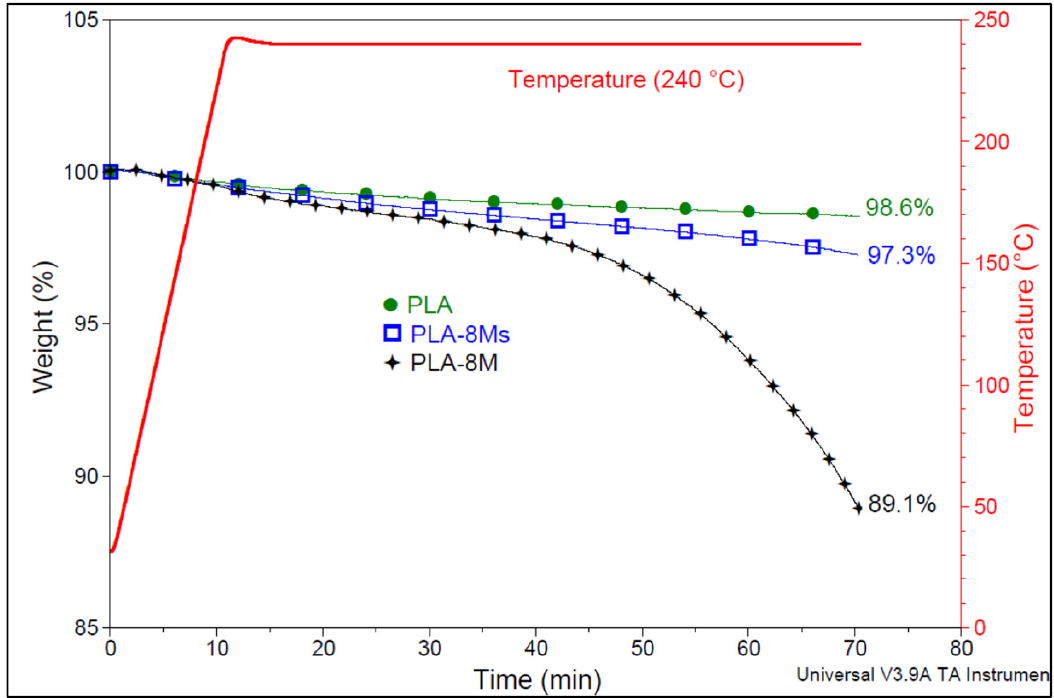
Figure 6. Comparative isothermal tests under air at 240 °C for PLA, PLA-8M, and PLA-8M nano-composites.